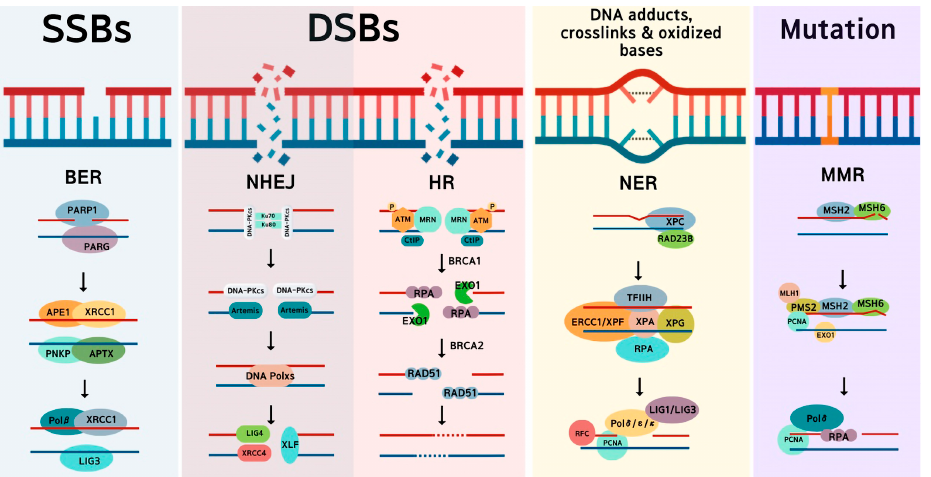
Figure 1. Types of DNA damage and their repair systems. Exogenous or endogenous insults cause strand breaks and base modification and mutation, and activate specific repair pathways corresponding to the types of DNA damage.